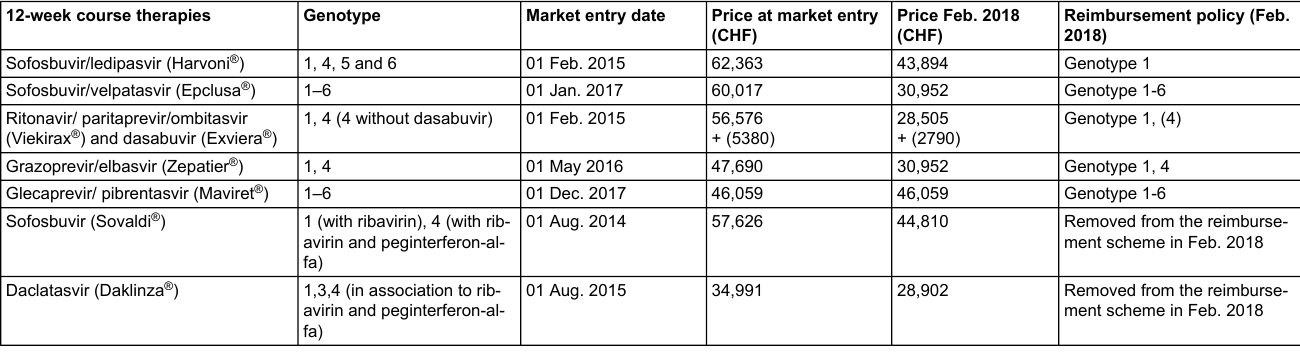
Table 1: Evolution of the availability and price of drugs against hepatitis C in